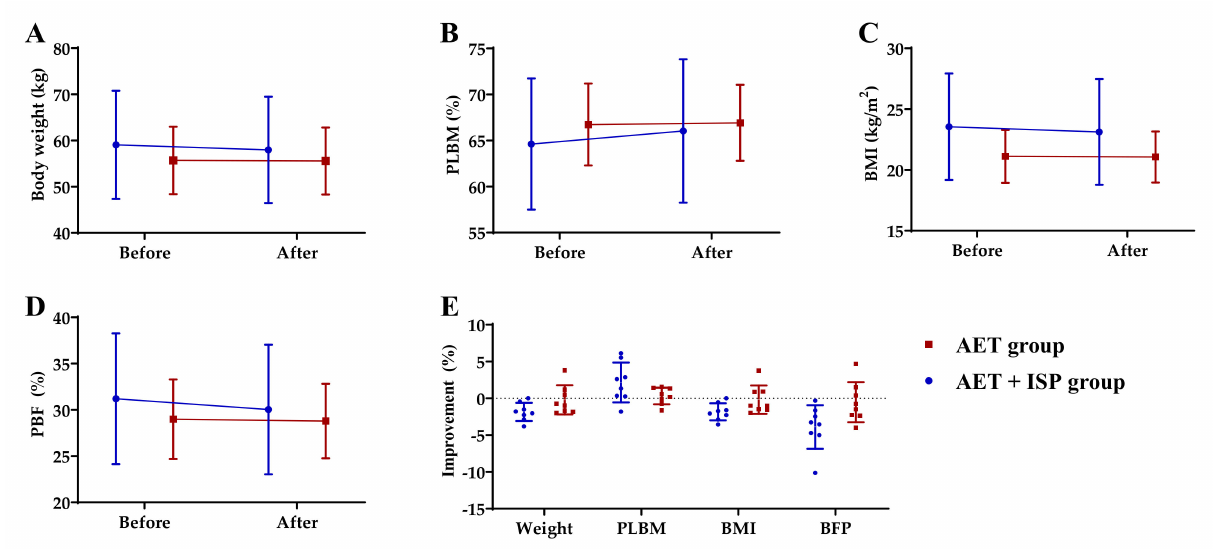
Figure 1. The changes in ( A ) body weight, ( B ) PLBM, ( C ) BMI, and ( D ) PBF for the AET and AET + ISP groups before and after intervention; ( E ) the improvement in body composition of the two groups, shown as a percentage, means the reductions in value for body weight, BMI and PBF, as well as the gain in value for